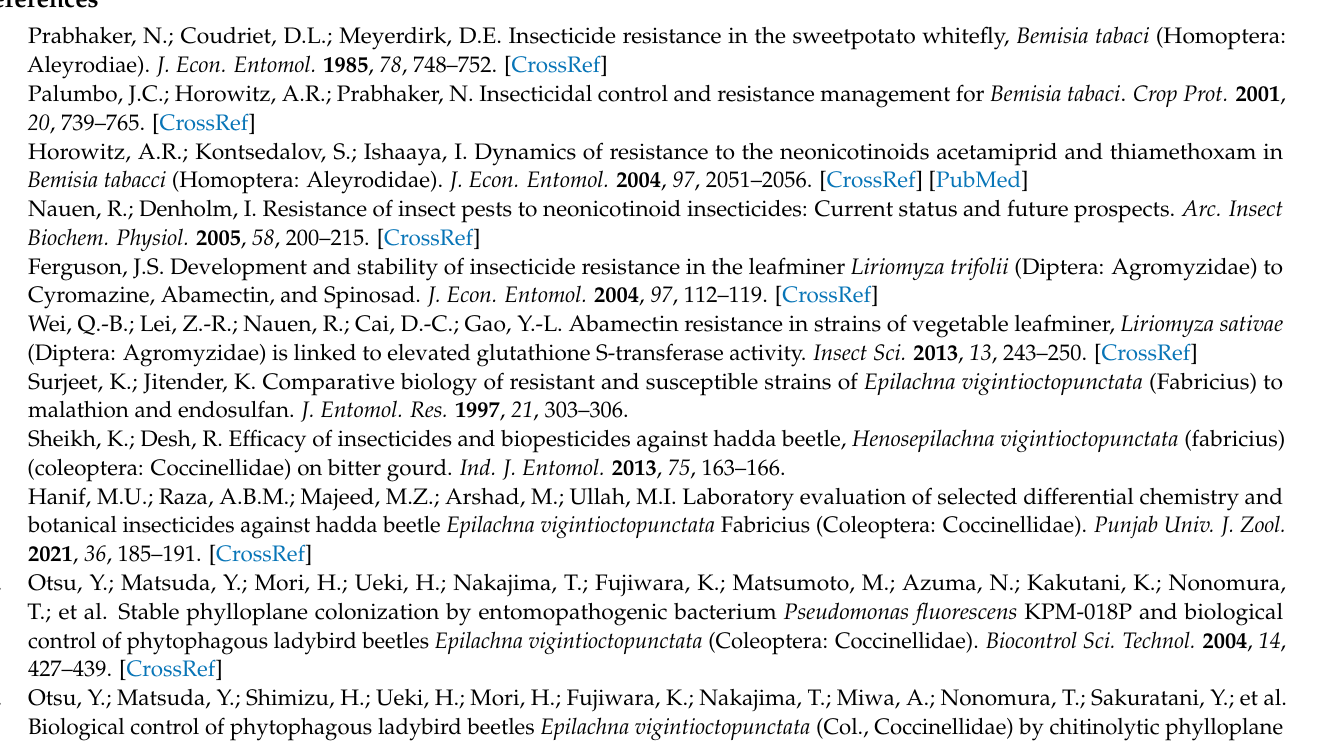
Figure S2: (A) Schematic representation of a single-charged dipolar electric field screen (SD-EFS), which consisted of a layer of insulated iron wires (ICWs) and grounded metal nets (G-MNs) on each side of the layer. (B) Single-charged dipolar electric field (SD-EF) formed in the space between the negatively charged ICWs (N-ICWs) and G-MNs (cross-sectional view). (C) A cabinet with lateral windows furnished with the SD-EFSs, Figure S3: (A) Diagram of the racket-shaped electrostatic flying insect catcher (EFIC). (B) Two layers of insulated conductor wires (ICWs) oppositely charged with two voltage generators. (C) The EFIC was portable and easy to operate on site in a greenhouse, Video S1: Capture of adult whiteflies with oppositely electrified insulator tubes of the yellow-colored double-charged dipolar electric field screen